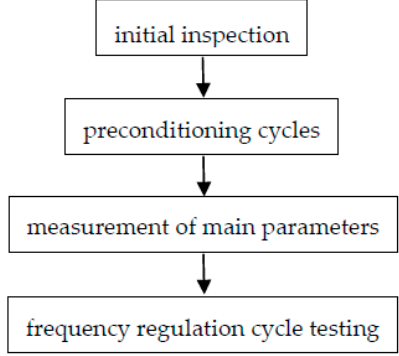
Figure 4. Flow-chart of the procedure agreed with manufactures.